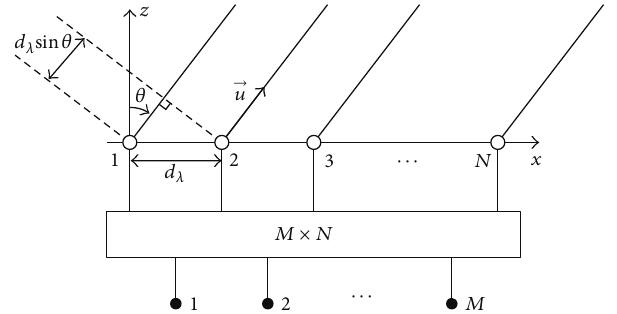
Figure 3: Multiple beam 𝑁 -element linear array parameters defini-